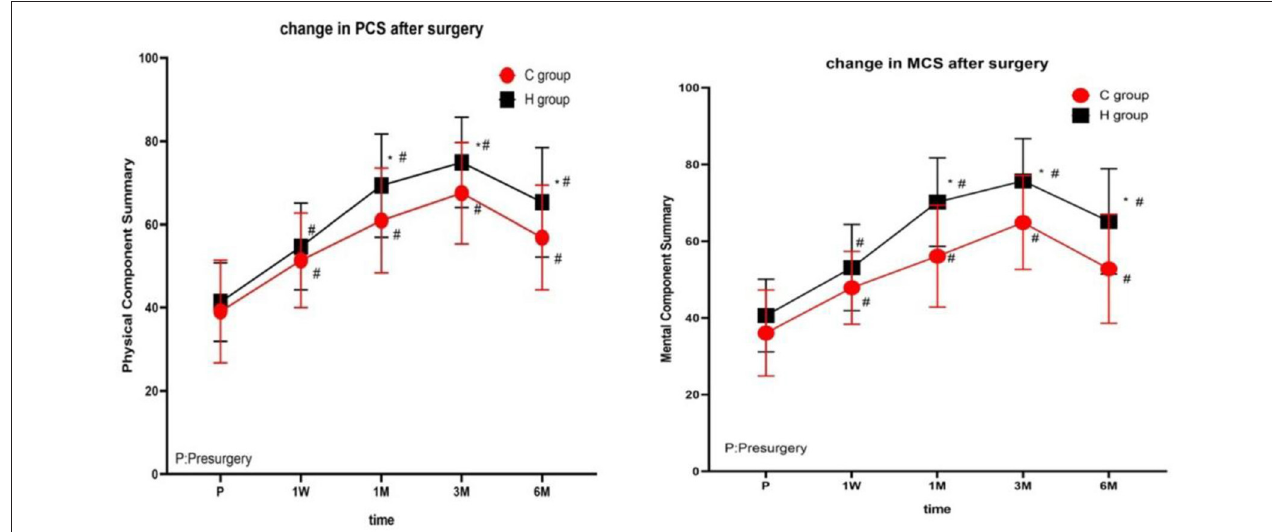
FIGURE 4 | The comparison of quality of life scores (SF-36) preoperative and postoperative in two groups. PCS, physical component summary; MCS, mental component summary. Results are represented as means ± SD. #Compared to preoperative, P < 0.05; *Compared with group C, P < 0.05.